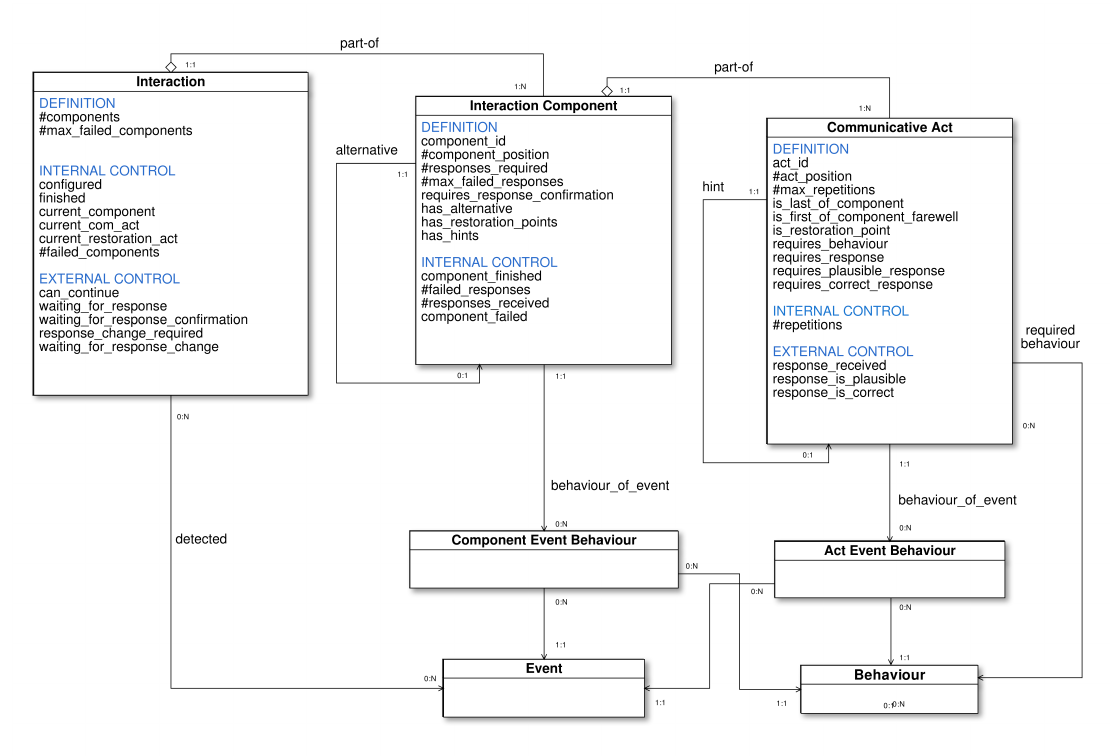
Figure 3. High level interaction conceptual knowledge